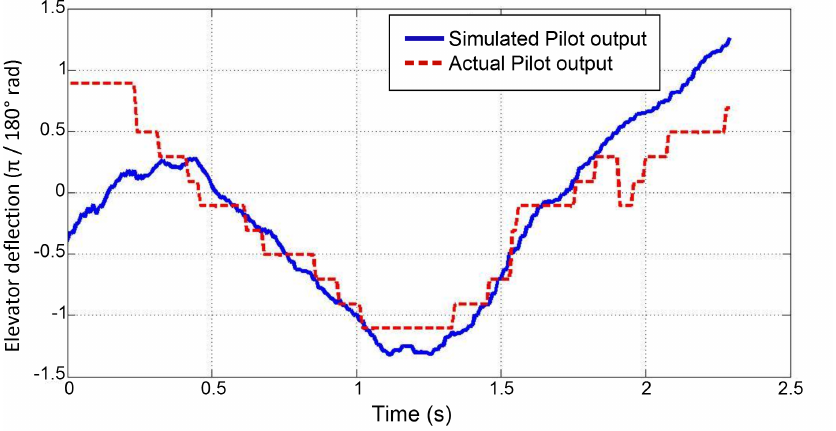
Figure 14. Validation example for lead-lag pilot model.